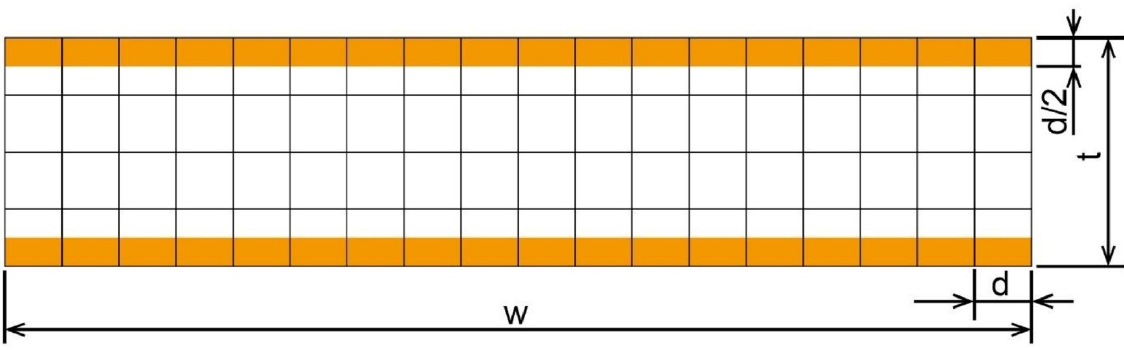
Figure 7. The surface layer model of the sheet samples at the micro-scale [24]. The curve can be used to fit the parameters k 1 , k 2 , n 1 , n 2 . The results are C G = 0.18, α = 0.34 [34], and m and M [35,36] are set as 2 and 3.06, respectively. The calculation results and the true stress–strain curve obtained from the experiments can be seen in Figure 3. The solid line represents the fitted result and the marker line represents the experimental result, showing that the fitted curve is in good agreement with the experimental